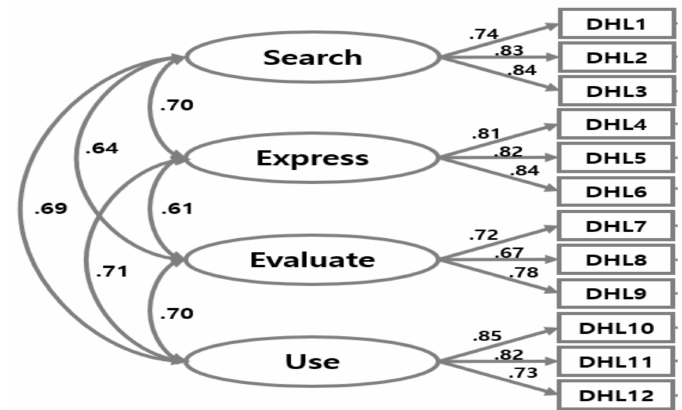
Figure 1. Results of confirmatory factor analysis for the